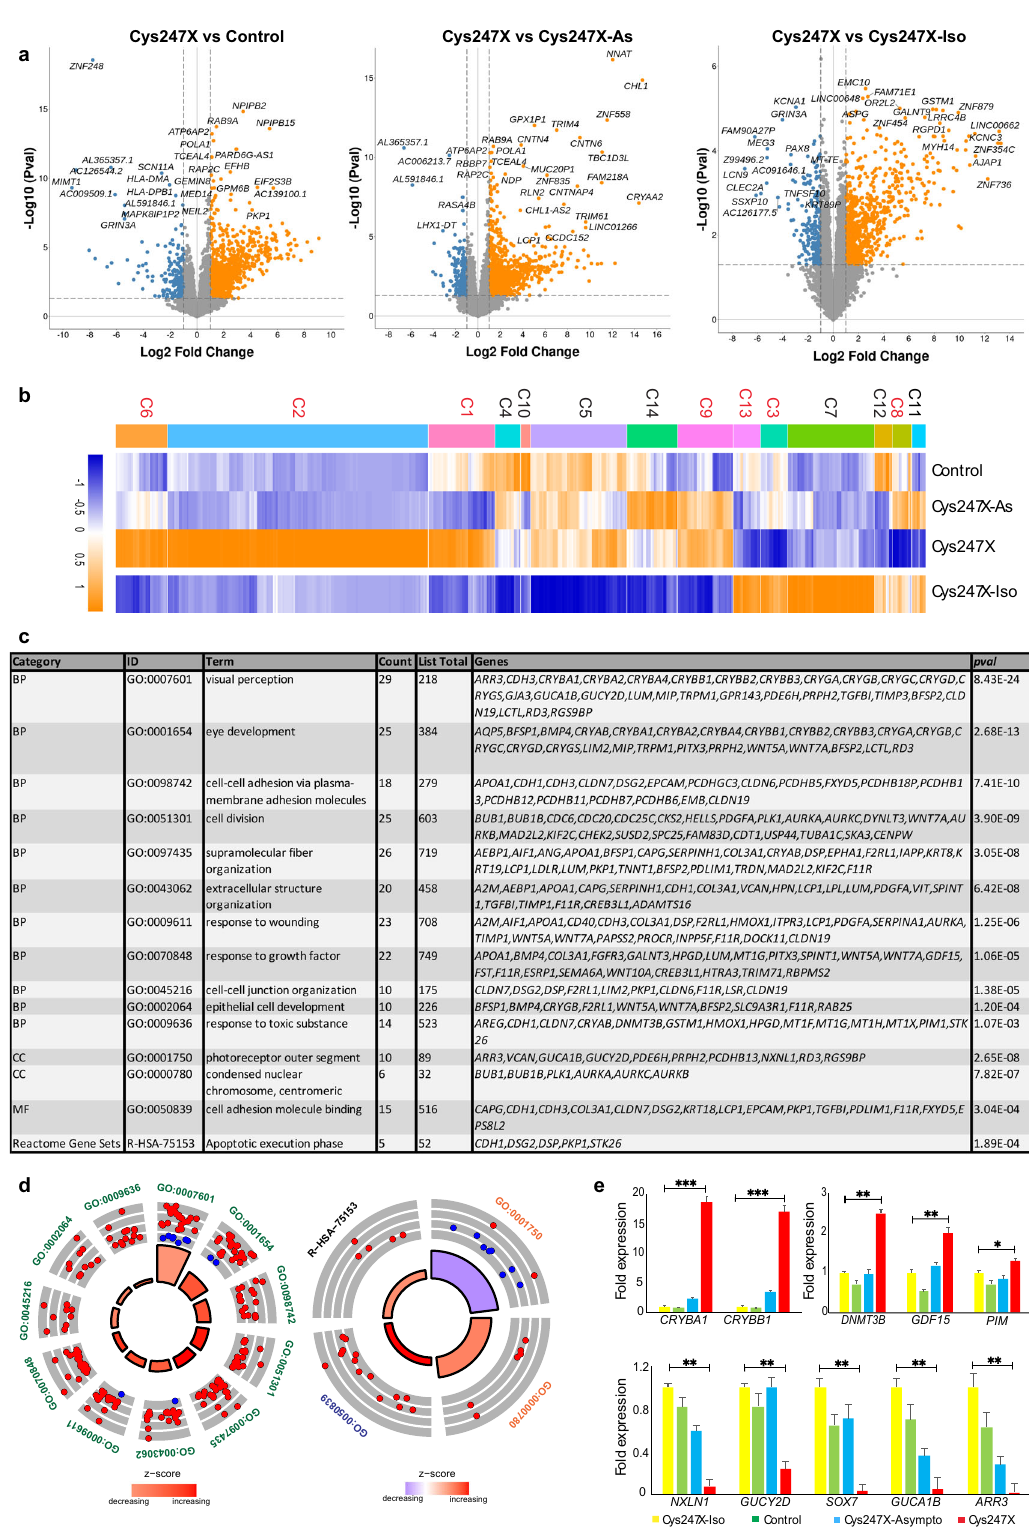
cells and retinal organoids in both cases. These PRPF31 mutations lead to the occurrence of a premature stop codon that probably results in null alleles and decreases amounts of functional PRPF31 protein in affected cells, as con fi rmed by western blot in RPE cells and retinal organoids. Notably, we generated isogenic CRISPR/